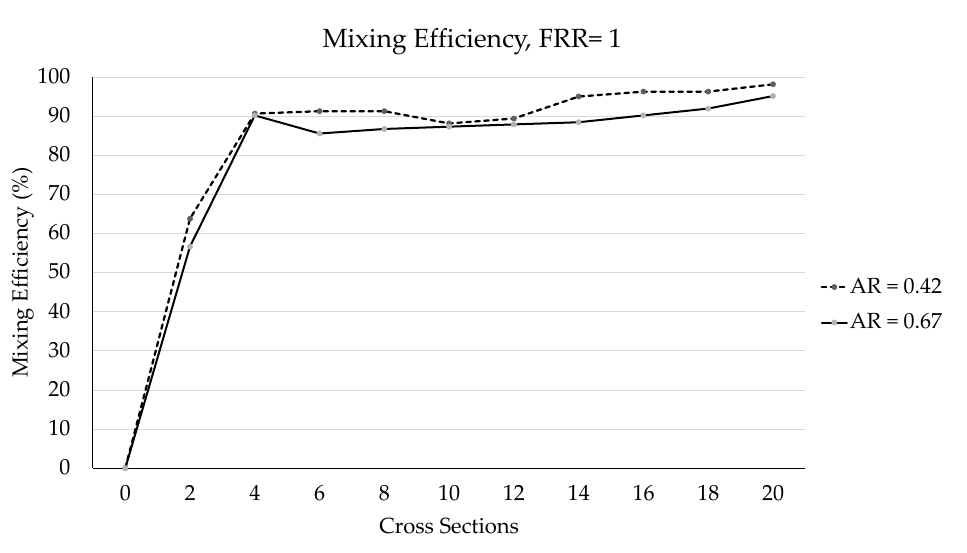
Figure 7. Mixing efficiency using the cross-sections shown in Figure 5 (r2, r4, r6, r8, ...): TFR = 18 mL/h, FRR = 1.